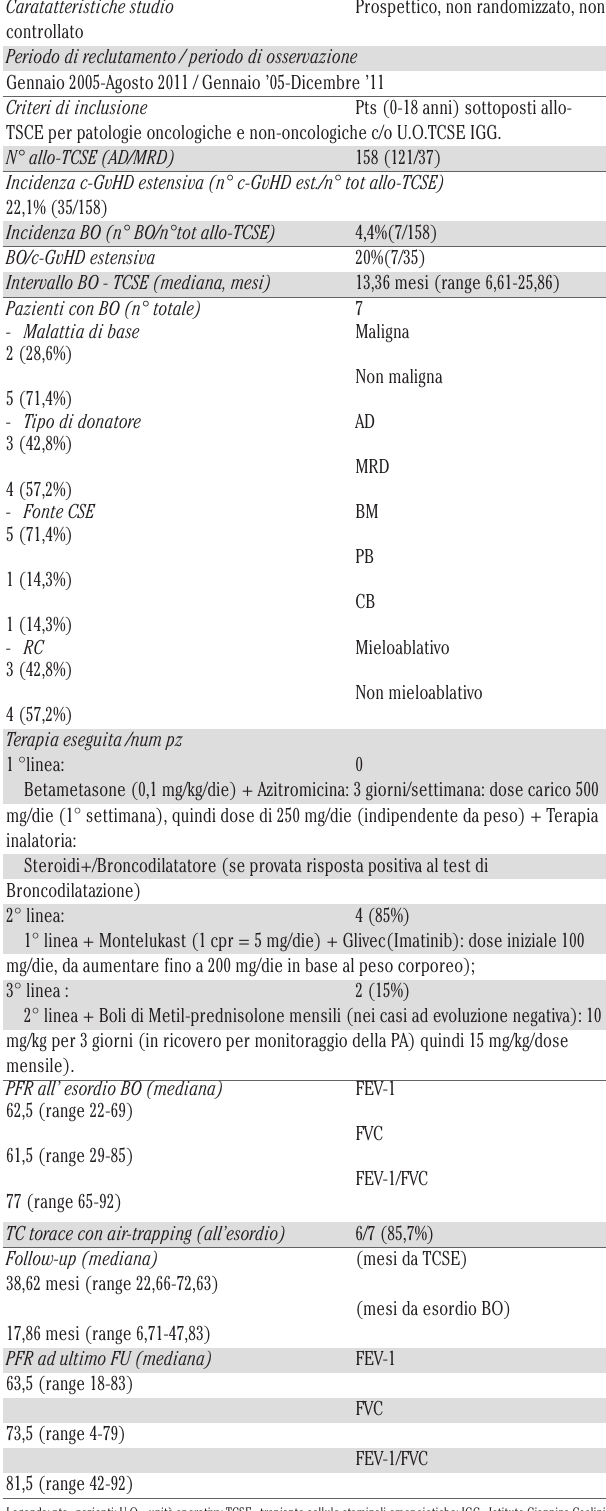
Tabella 1: CARATTERISTICHE STUDIO E PAZIENTI Caratatteristiche studio Prospettico, non randomizzato,